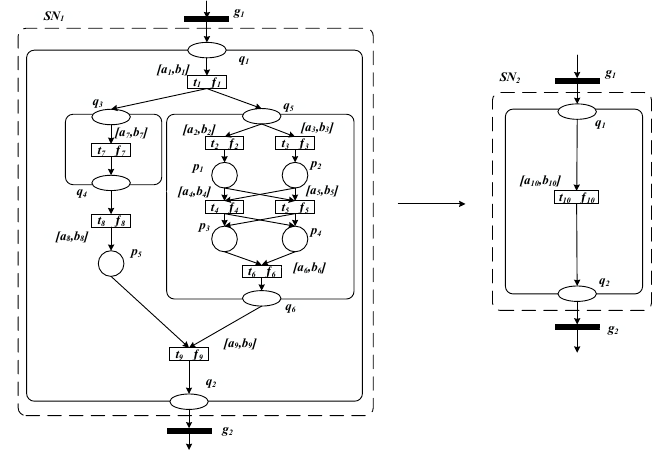
Figure 4. An example of TQ- type internal subnet reduction rule.